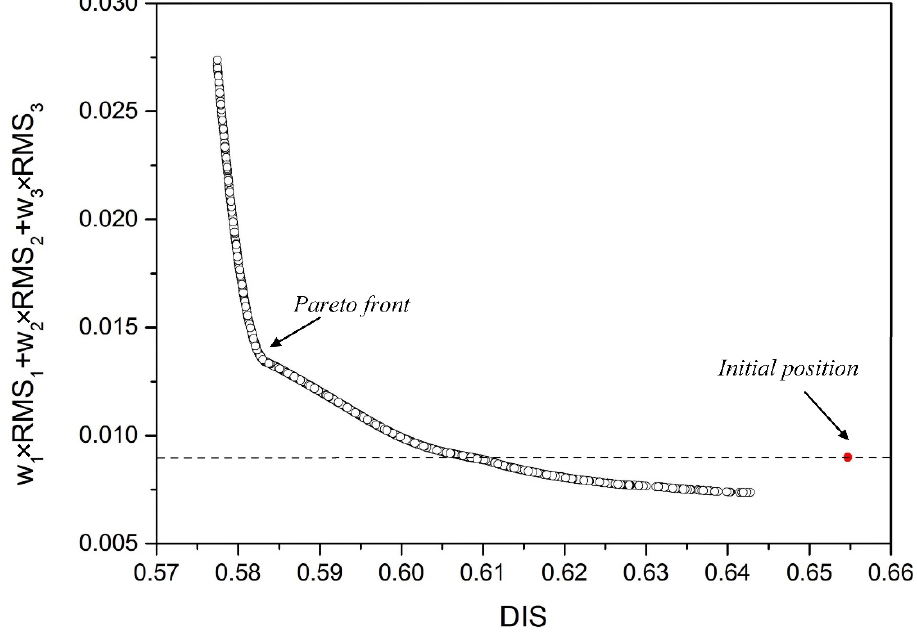
Figure 8. Comparison of the Pareto solution set and the initial state.